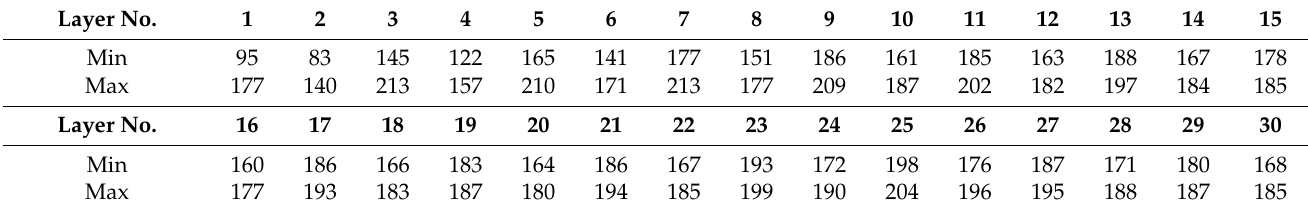
Table 2. Max. and min. temperature in substrate during the deposition of each